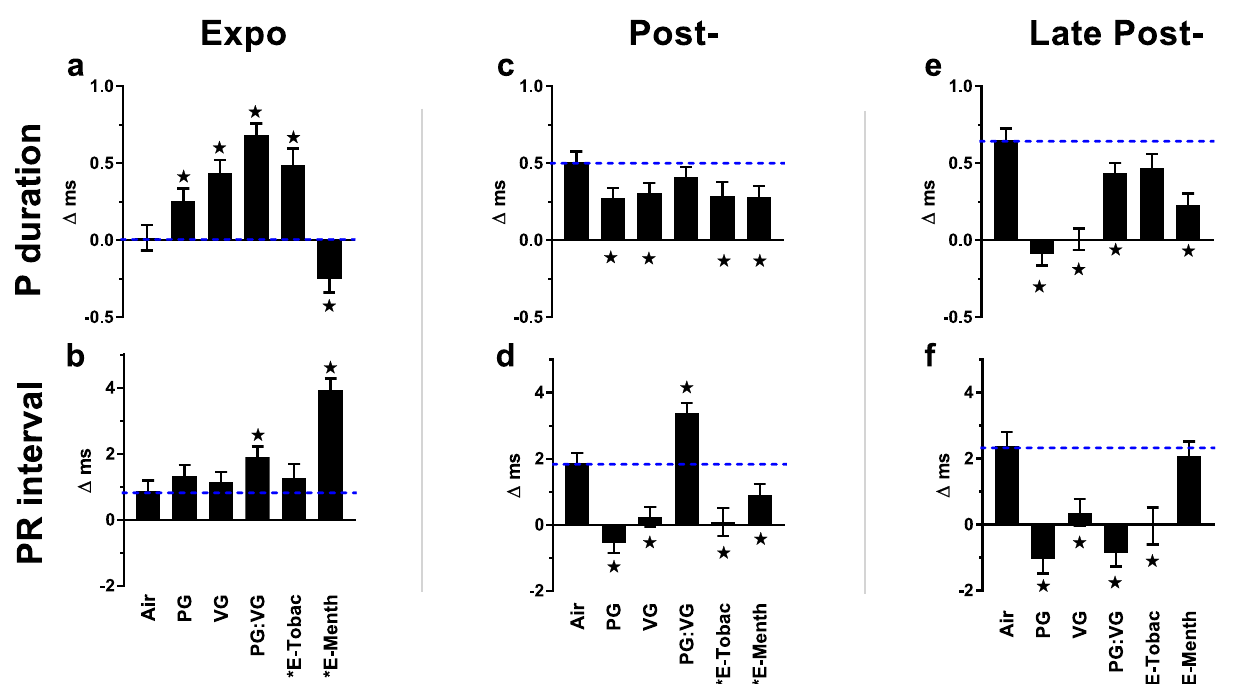
Fig. 3 | Inhalation exposure to E-cig aerosols alters supraventricular conduc- tion. Barsrepresent least square means (±SEM) of change from 5-minbaseline in P durationandPRintervalaccordingtoexposurephases( a – f ).DashedlinesmarkAir mean. Signi fi cance determined by two-sided P <0.05 (vs. Air: star) in mixed model analyses.Blackasteriskindicatesnicotinepresent. “ E-Tobac ” and “ E-Menth ” denote